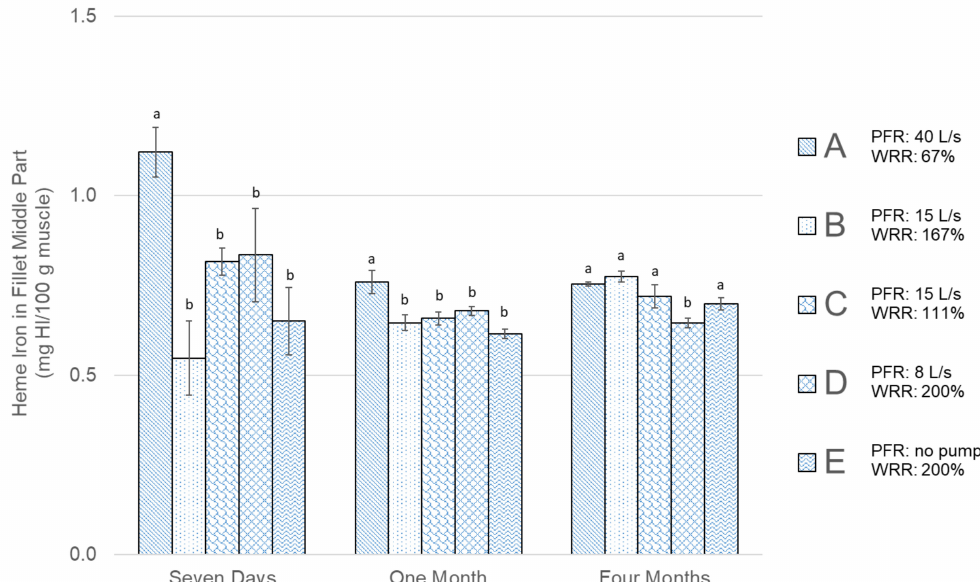
Figure 6. Heme Iron (g HI / 100g muscle) results for all groups shown in Table 1. The error bars show the standard error of the mean values ( µ ± σ µ ), n = 6. Di ff erent letters (a and b) within storage times represent significant di ff erences between experimental groups ( p <